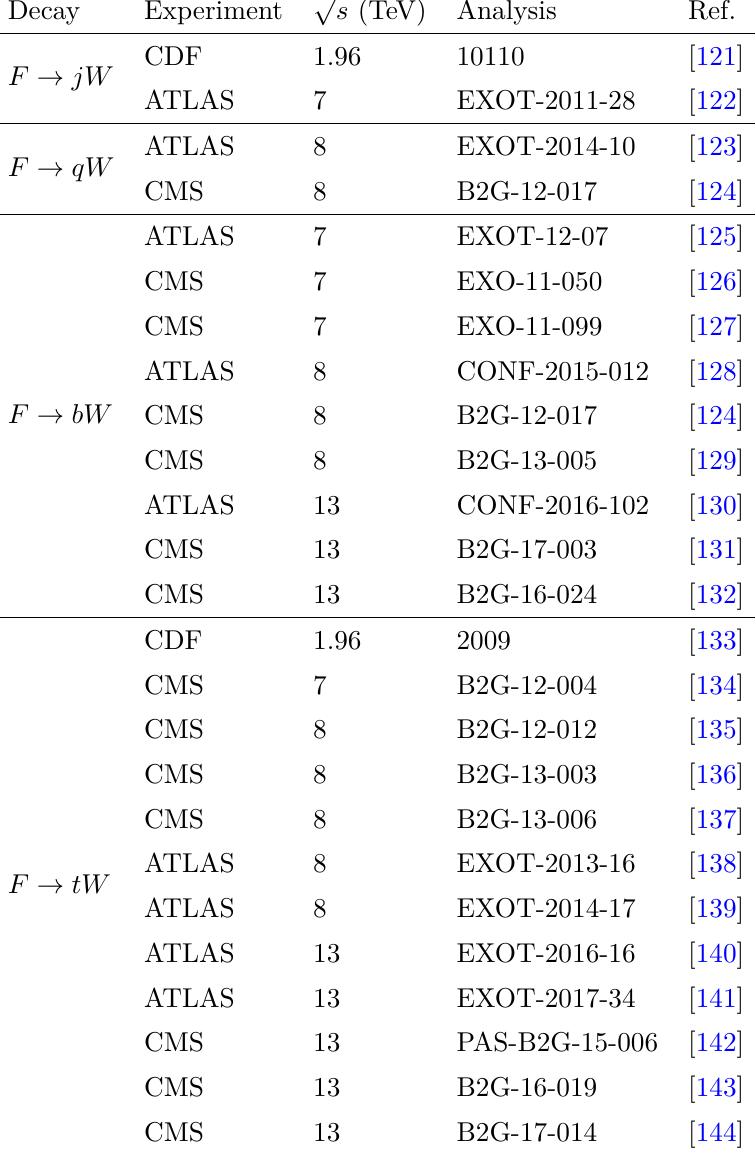
Table 10. Experimental analyses of heavy quark decays we use to judge the fitness of our points. Here, j refers to a light quark or b jet, and q refers to a light quark